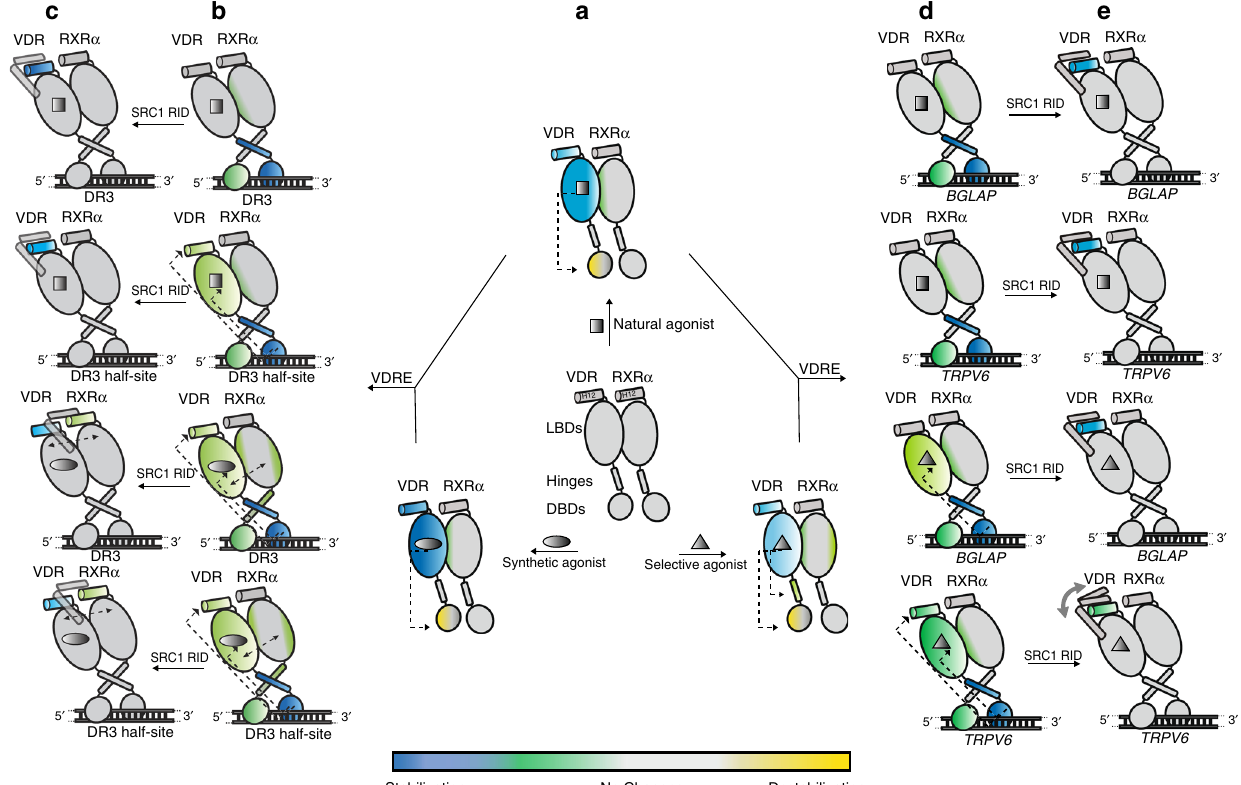
Fig. 6 Schematic representation of VDRRXR α heterodimer activation by different ligand and DNA. Protein stabilization induced by interactions of the ligand, DNA and SRC1 RID (as measured by the differential HDX pro fi les) is shown in blue and green color, whereas destabilization is shown in yellow color. Regions with no signi fi cant change are colored gray. VDRRXR α heterodimer is shown with co-receptors ’ LBDs including AF2, hinge domains, and DBDs. Allosteric intra-molecular and inter-molecular communications within co-receptors are indicated by black dotted arrow. a Synthetic agonists; Cmpd ’ s 1 and 2, induce greater stabilization in VDR LBD compared to that of a natural ligand 1,25D3. VDRM Cmpd3 exhibits relatively weak stabilization within AF2. Binding of all ligands induce allosteric destabilization within the VDR DBD. Additional stabilization was observed within the VDR hinge and H3 of RXR α upon binding to Cmpd3. The heterodimer interface becomes more stable upon ligand binding. b Binding of 1,25D3-bound heterodimer to DR3 and DR3 half-site result in stabilization within the DBDs and VDR hinge. Interaction with DR3 half-site leads to intra-domain allosteric stabilization in VDR LBD and AF2 that are not observed upon DR3 binding. In contrast, the presence of synthetic agonist and DNA with heterodimer drive stabilization in the DBD and hinge of both co-receptors and VDR AF2. c Large stabilization was observed in VDR AF2 upon binding SRC1 RID, whereas stabilization in RXR α AF2 was only observed when heterodimer is bound to synthetic agonist and DNA. d Cmpd3 could modulate heterodimer dynamics in an alternative mechanism, in which allosteric stabilization in VDR AF2 occurs upon heterodimer binding to TRPV6 rather than BGLAP . In contrast, neither BGLAP nor TRPV6 alter the conformational of VDR LBD when VDRRXR heterodimer is bound with 1,25D3. e Binding of SRC1 RID results in less stabilization at VDR AF2 when heterodimer is associated with Cmpd3 and